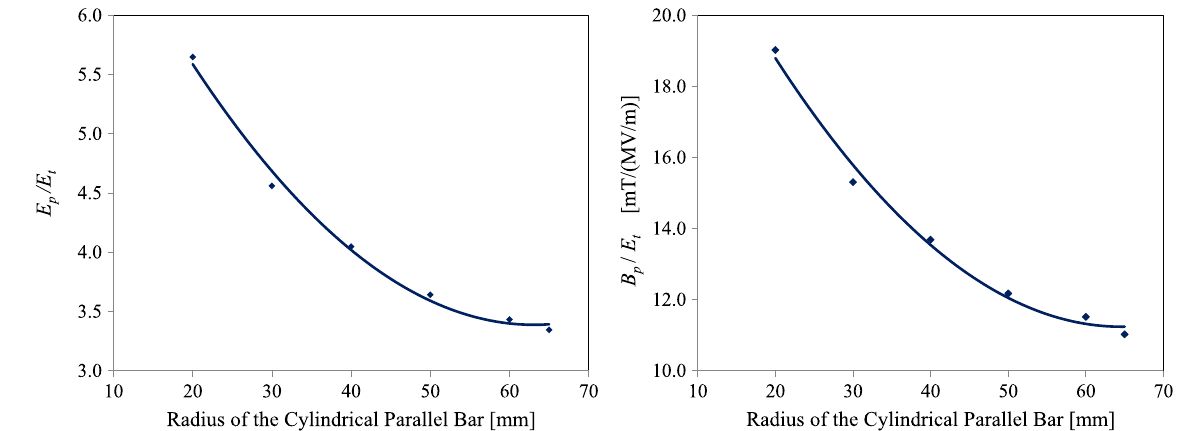
FIG. 9. Ratios of peak surface electric field ( E p ) and magnetic field ( B p ) to the transverse electric field ( E t ) with varying radius of cylindrical-shaped parallel bars [Design (A)].